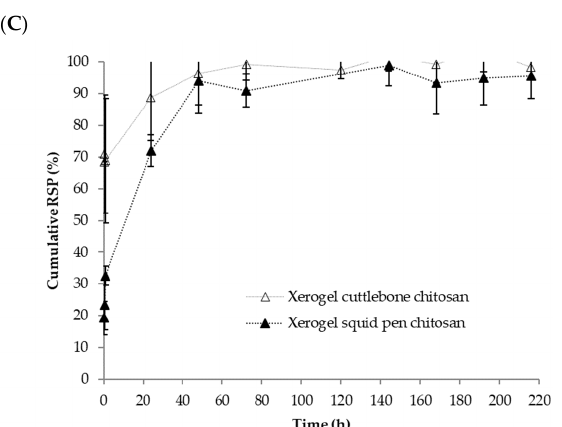
Figure 7. Cumulative release of risperidone from different formulations: ( A ) Hydrogels, ( B ) Injectables, ( C ) Xerogels.